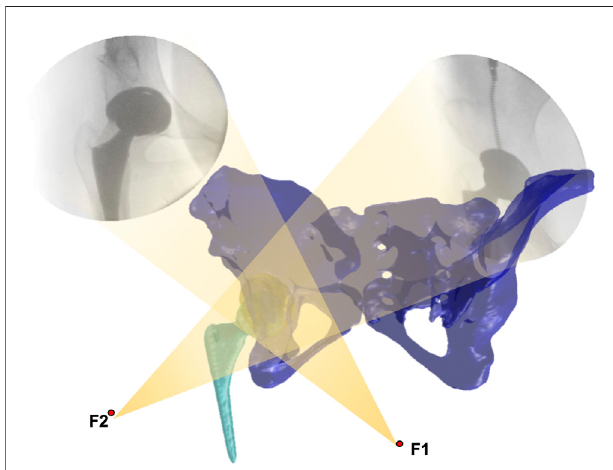
FIGURE2| Virtualenvironmentofthedual fl